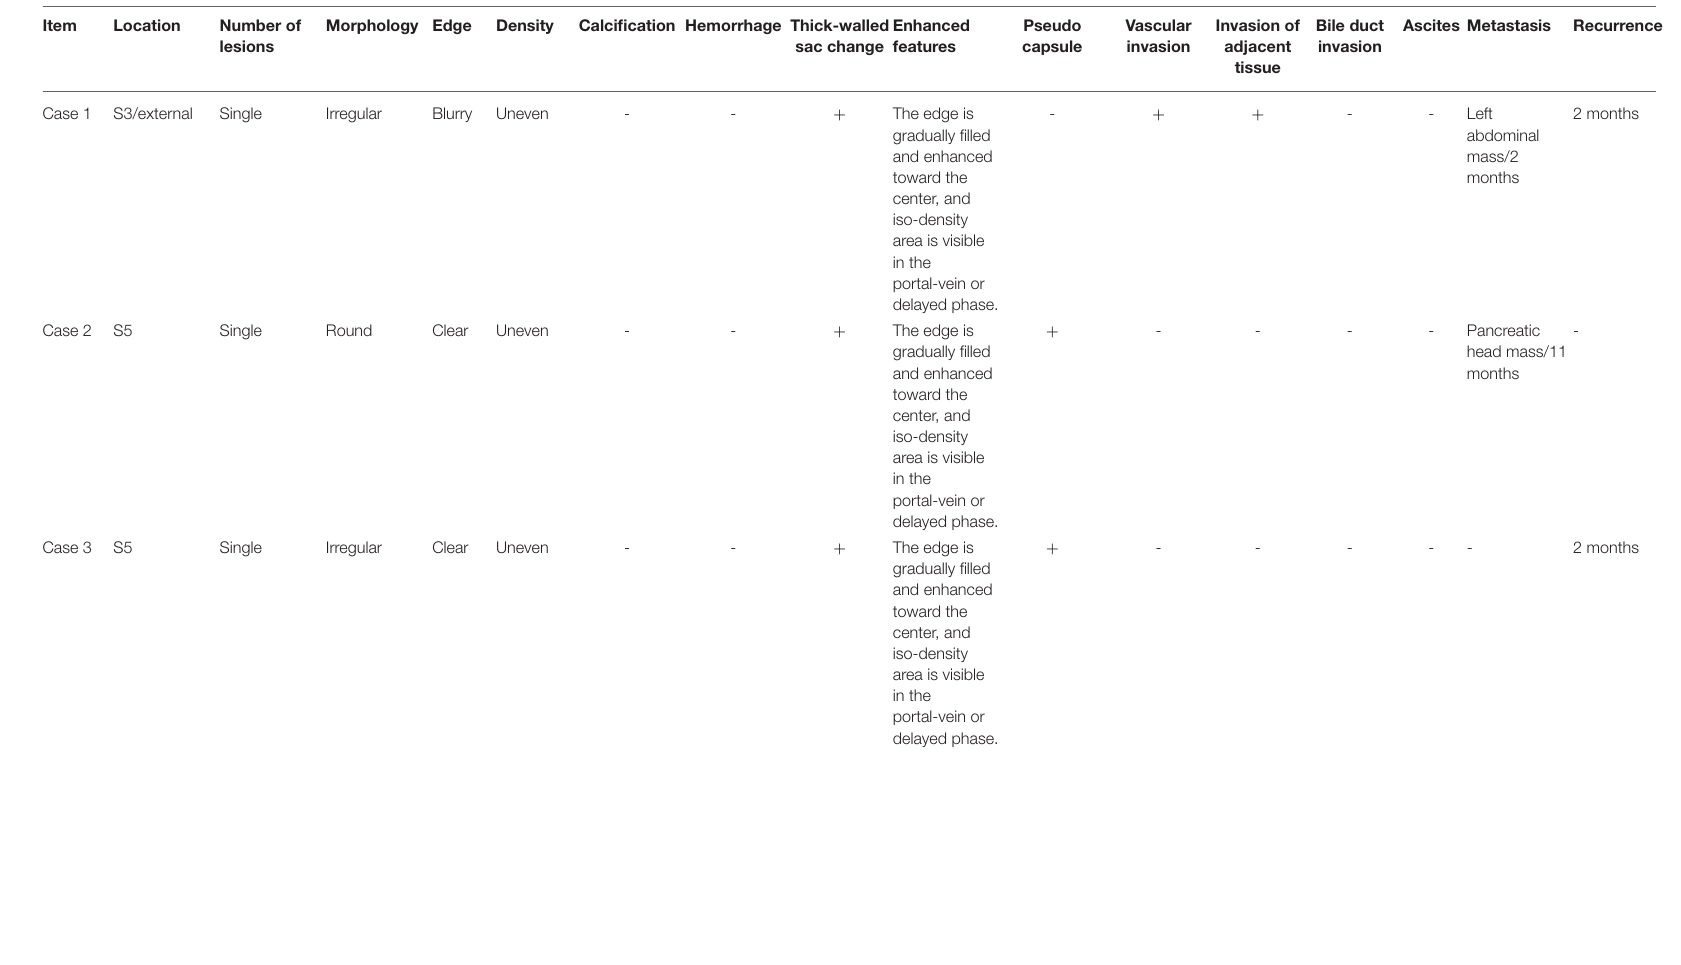
TABLE 3 | CT features of three cases with